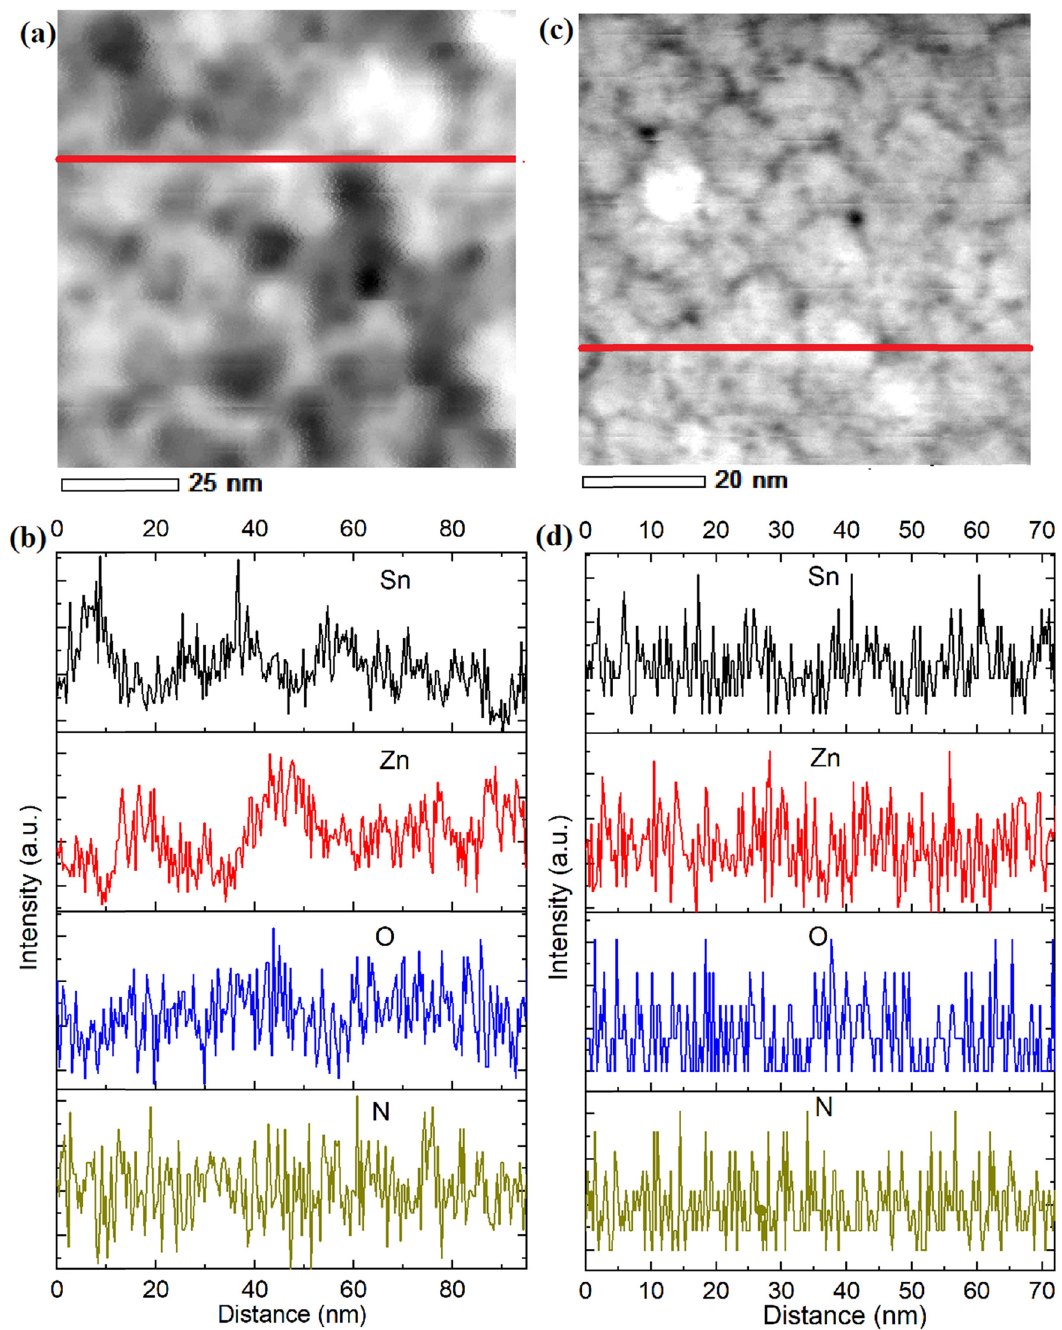
Figure 7: ( a ) and ( b ) are STEM image and EDS line pro fi le analyses of ZTNO thin fi lm on Si ( 100 ) substrate with 0.65 Zn/ ( Zn + Sn ) composition, respectively. ( c ) and ( d ) are STEM image and EDS line pro fi le analyses of ZTN thin fi lm on Si ( 100 ) substrate with 0.72 Zn/ ( Zn + Sn ) composition, respectively. The red lines in ( a ) and ( c ) represent the selected regions for EDS line pro fi le analyses ( authors ’ original work )